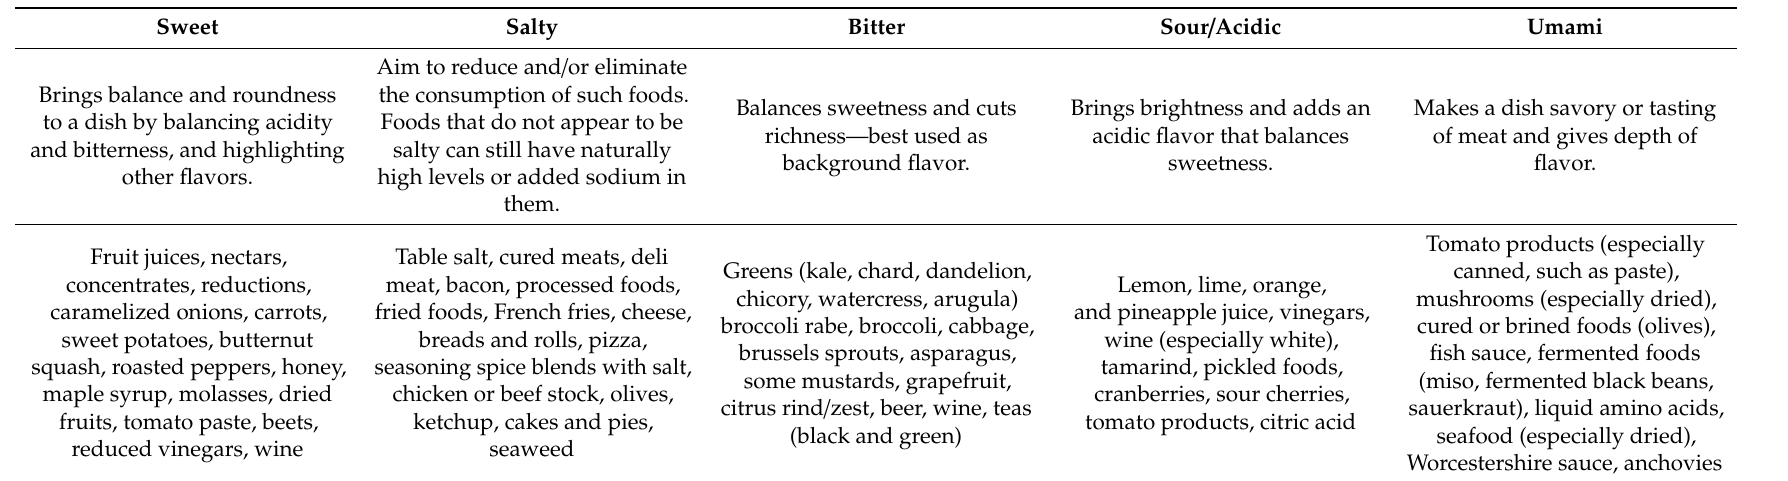
Table 2. Balancing complementary flavors in cooking.